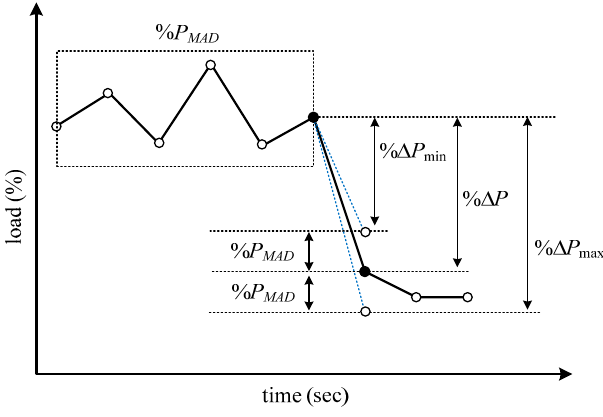
Figure 2. Percentage load variation and mean absolute deviation of the direct method.